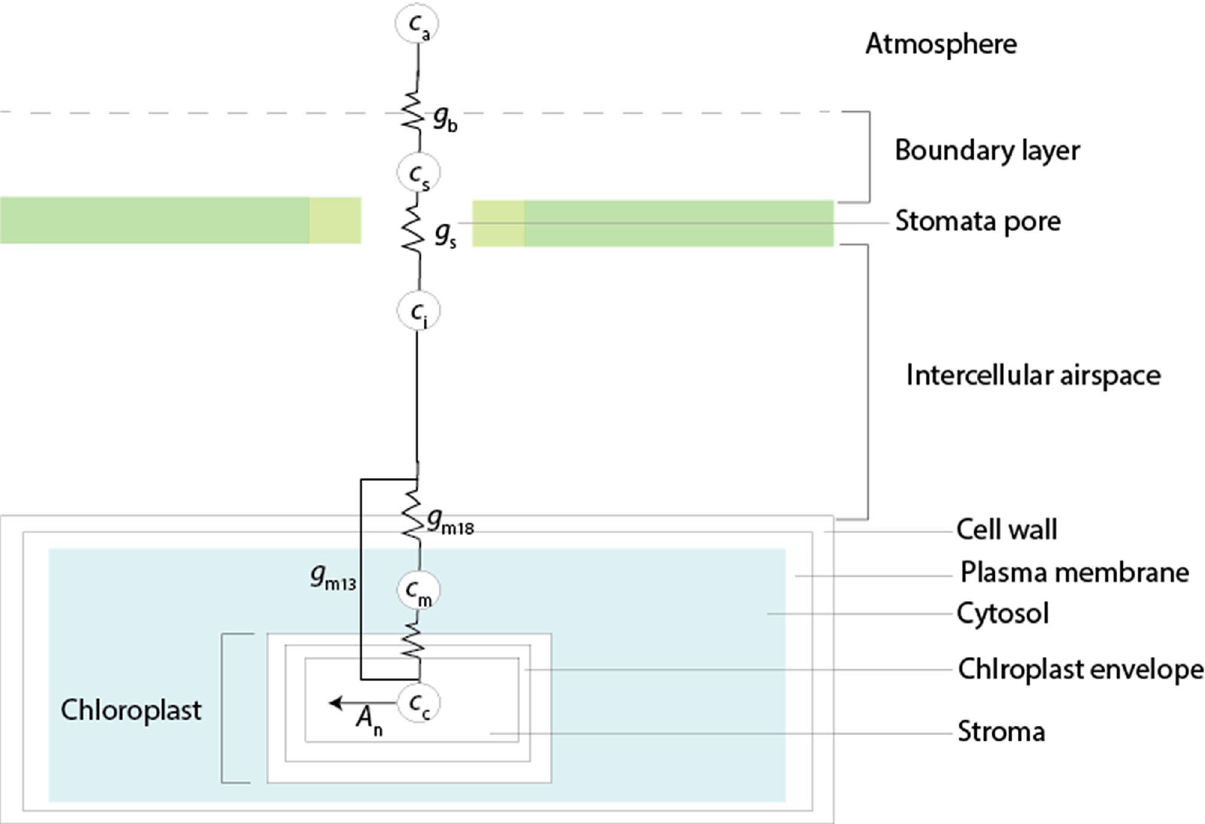
Figure 1. Schematic illustration of CO 2 exchange fluxes, concentrations and conductivities during photosynthetic gas exchange. Net photosynthetic CO 2 uptake in a leaf generates a concentration gradient over the leaf where c a is the CO 2 concentration of the air, c s the CO 2 concentration at the leaf surface, c i is the CO 2 concentration in the intercellular air space, c m is the CO 2 concentration in the mesophyll, i.e., the site of CO 2 - H 2 O exchange and c c the CO 2 concentration in the chloroplasts, the site of CO 2 uptake. The g b is the boundary layer conductance of CO 2 from the atmosphere to the leaf surface, the stomatal conductance g s quantifies the gas exchange through the stomatal opening, g m13 is the mesophyll conductance to the site of carbon uptake and g m18 is the mesophyll conductance to the site of CO 2 -H 2 O